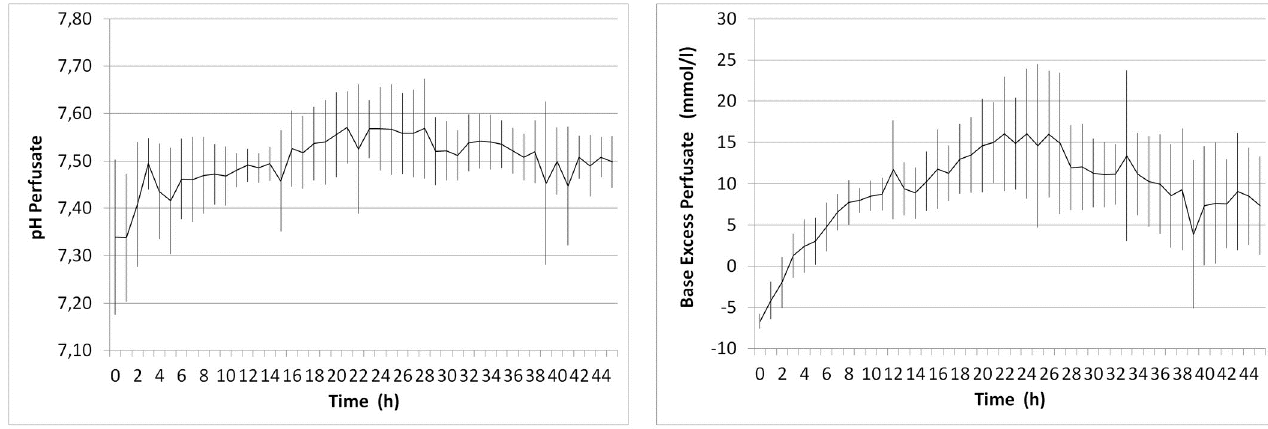
Fig 6. pH and base excessduring normothermic organ preservation. Acid—base homeostasis was sustaineduntil the end of organ preservation solely dependent on autoregulation of the perfused liver.